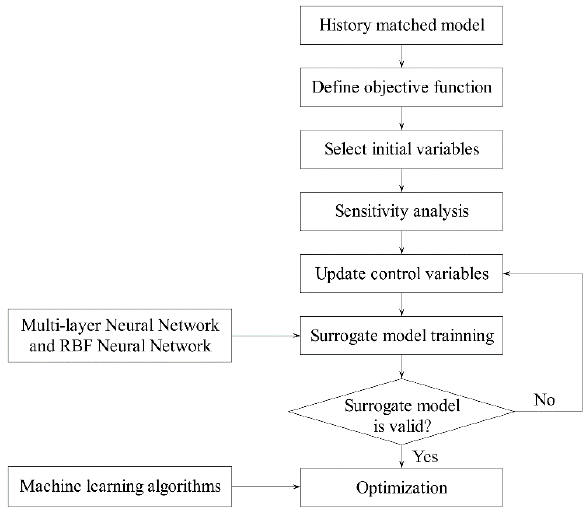
Figure 16. Flowchart of the optimization framework (modified from [222]).